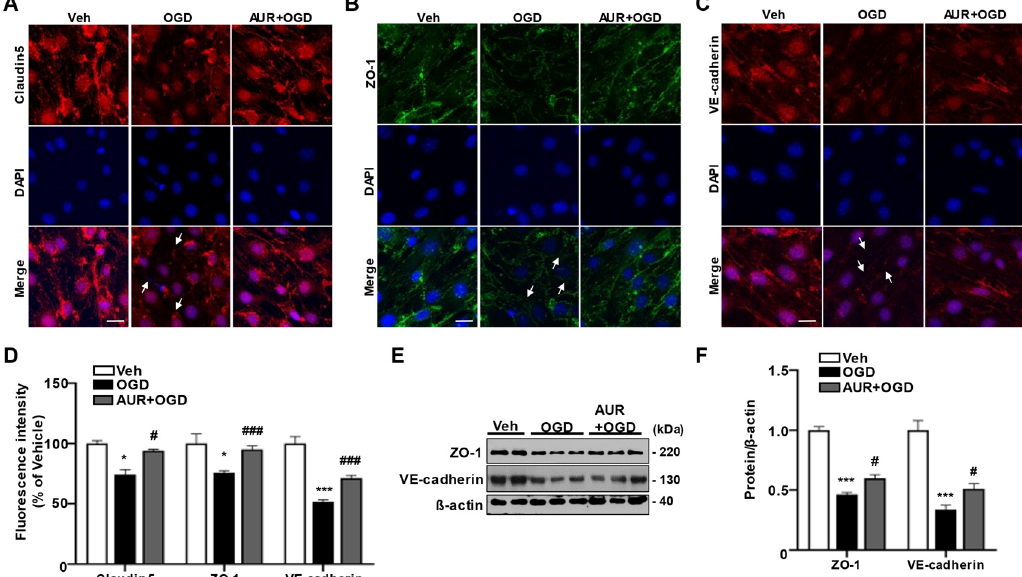
Figure 4. Protective effects of AUR pretreatment on the reduction of junctional protein by OGD in bEnd.3 cells.bEnd.3 cells were incubated in OGD condition for 3 h after treated with vehicle or 1 µM AUR 24 h. bEnd.3 cells were stained with claudin-5 (red) ( A ), ZO-1 (green) ( B ) and VE-cadherin (red) ( C ) with DAPI (blue); Scale bar: 20 µm. Arrows indicate junctional protein disruption. ( D ) Relative fluorescence intensity of markers was quantified using ImageJ. ( E ) ZO-1 and VE-cadherin expression were analyzed by Western blot with bEnd.3 cells incubated in OGD condition for 3 h after treatment of vehicle or 1 µM AUR for 24 h. Data are presented as mean and ± SEM of three independent experiments (* p < 0.05, ** p < 0.01, *** p < 0.001 compared to Veh, # p < 0.05, ### p < 0.001 compared to OGD).